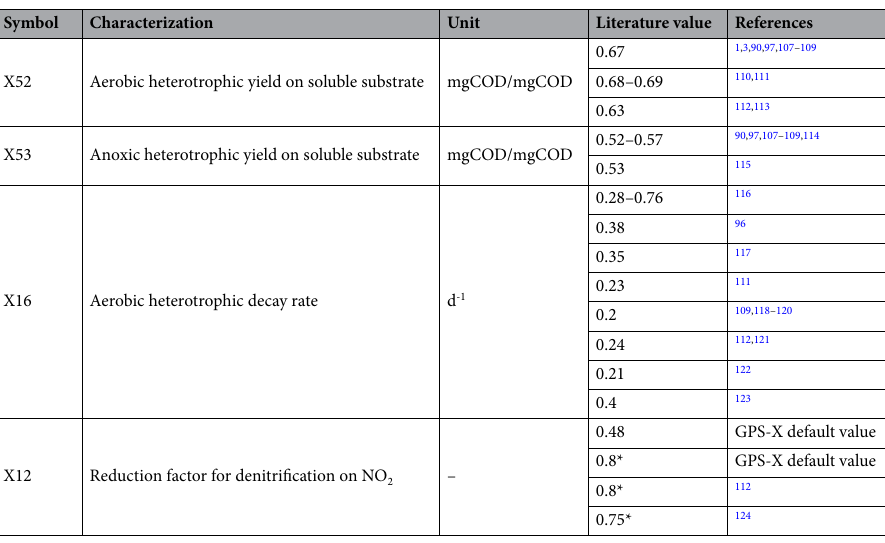
Table 6. Literature values for kinetic and stoichiometric parameters deemed influential (> 0.05). *Total reduction factor for denitrification (NO 2 and NO 3 ) .